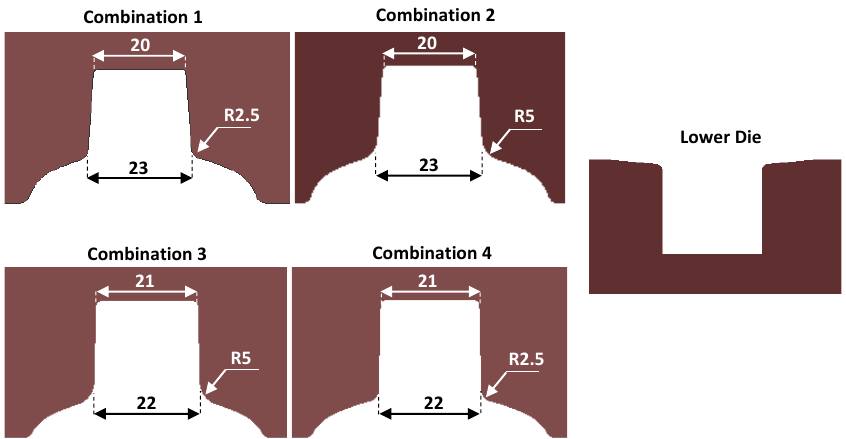
Figure 2. Head forming dies resulting from the hub dimensions in mm.